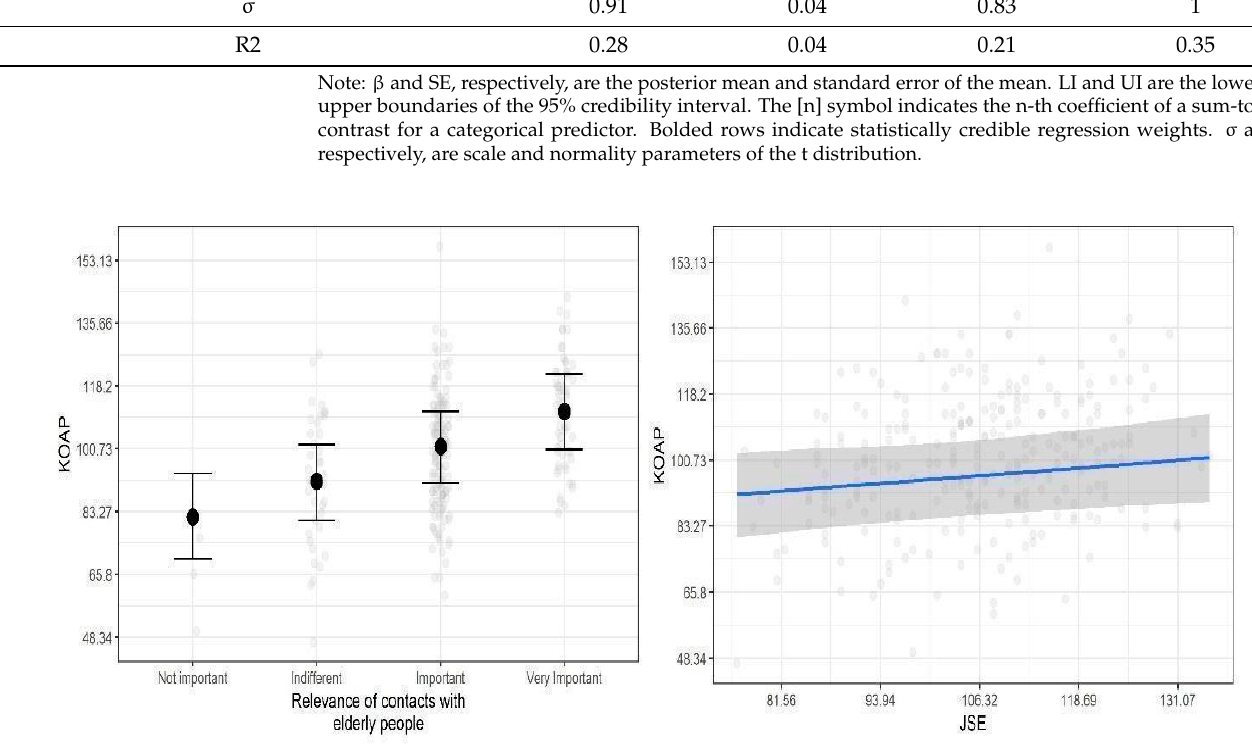
Figure 1. Posterior medians (points and blue line) of the predicted mean KOAP scores as a function of credible predictors. Vertical lines and shaded areas are 95% credible intervals. Grey transparent points show data. Note: relationship between KOAP and JSE.